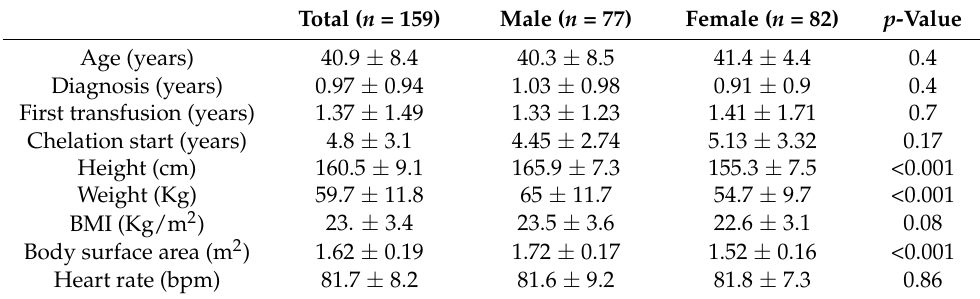
Table 1. Population clinical characteristics.